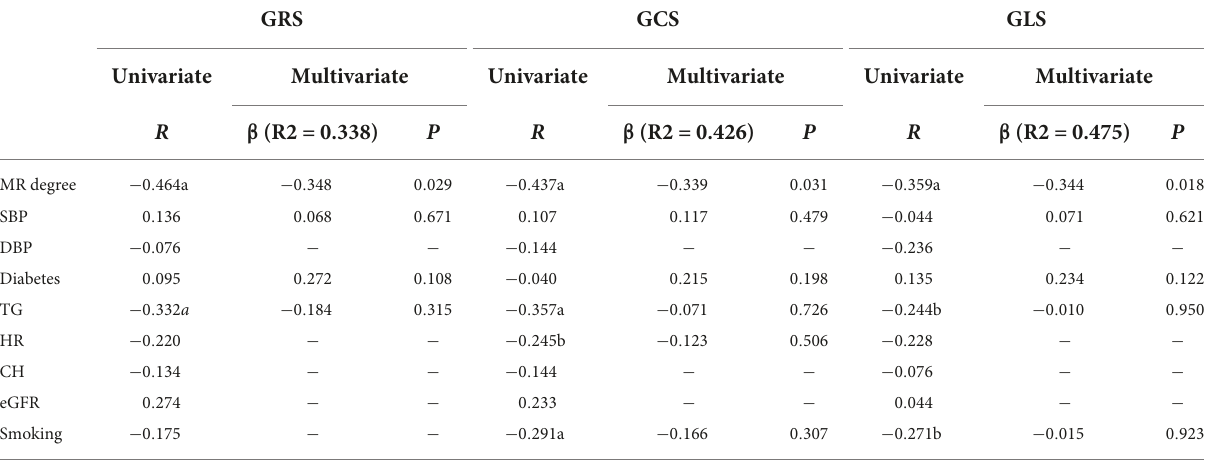
TABLE 5 Univariate and multivariate analysis between clinical indexes and LV global PS among hypertensive patients showing MR. GRS GCS GLS Univariate Multivariate Univariate Multivariate Univariate